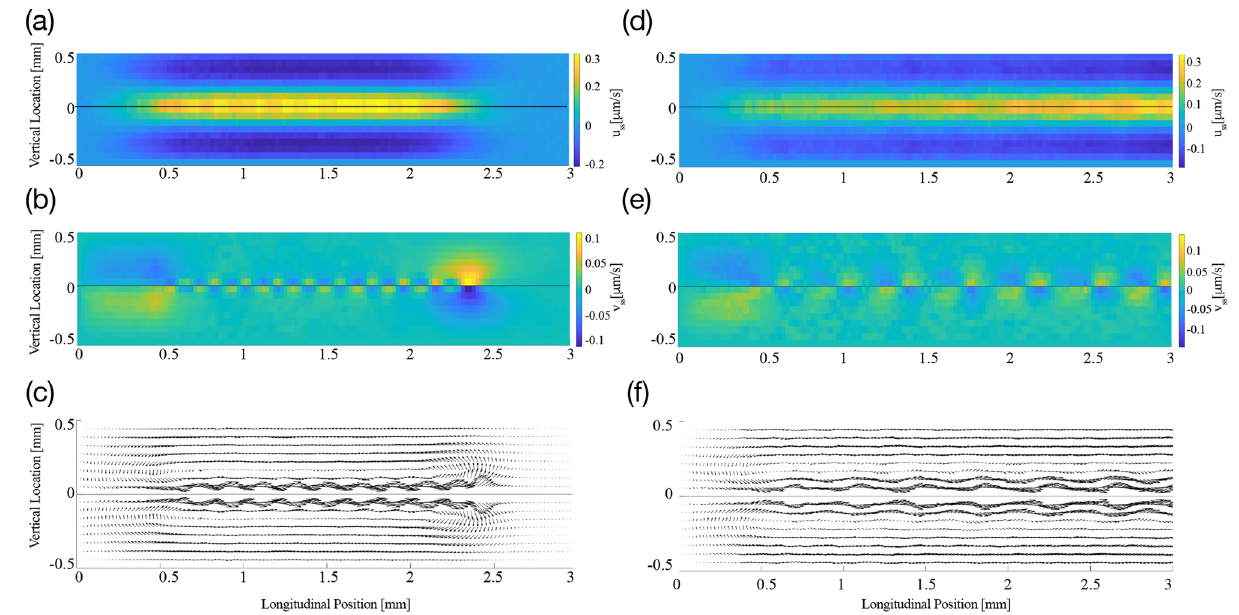
Figure 6. Steady streaming induced by multi-frequency stimulation at 80 dB SPL. ( a – c ), The velocities of steady streaming that results from stimulation at frequencies whose individual basilar-membrane waves peak 170 µ m apart from one another. ( a ) The longitudinal fluid flow has a significant at a spatial distance of δ = amplitude in the extended region from 0 to 2.5 mm, where the waves induced by the individual waves peak. ( b ) The vertical velocity is strongest at the beginning and at the end of that region, that is, near the cochlear base